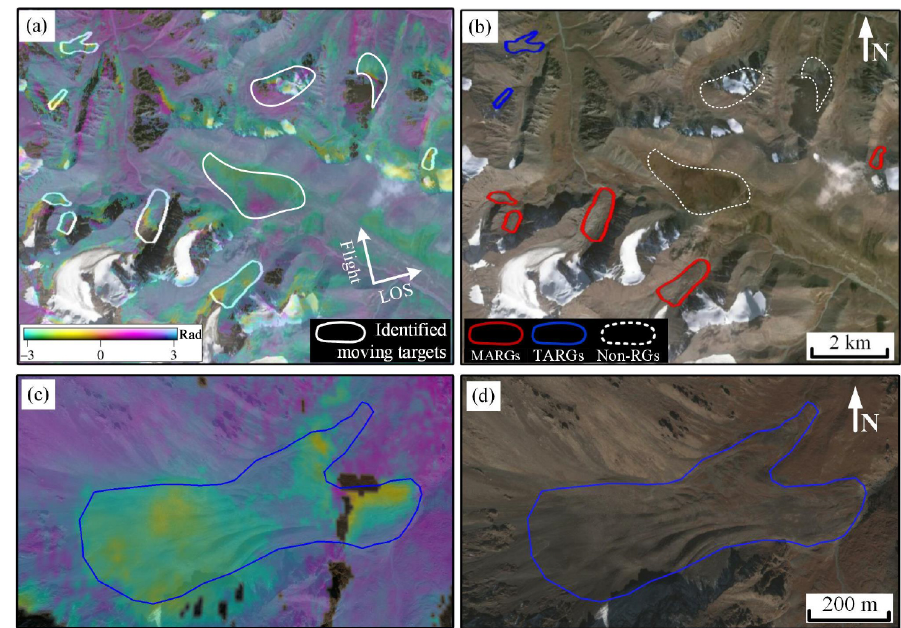
Figure 3. Examples of the identified active rock glaciers in the zones “Z” shown in Fig. 1. (a) shows the wrapped interferometric phase (in radians) for the pair 20070902–20071018 (Path 501). The solid white polygons denote the identified moving targets. (b) shows the corresponding Google Earth image, in which the red and blue polygons denote the identified MARGs and TARGs, respectively. The dashed white polygons denote moving targets that are not rock glaciers (labeled as “Non-RGs”). (c) and (d) show the interferometric phase and optical image for the rock glacier in the northwest corner of (a ),